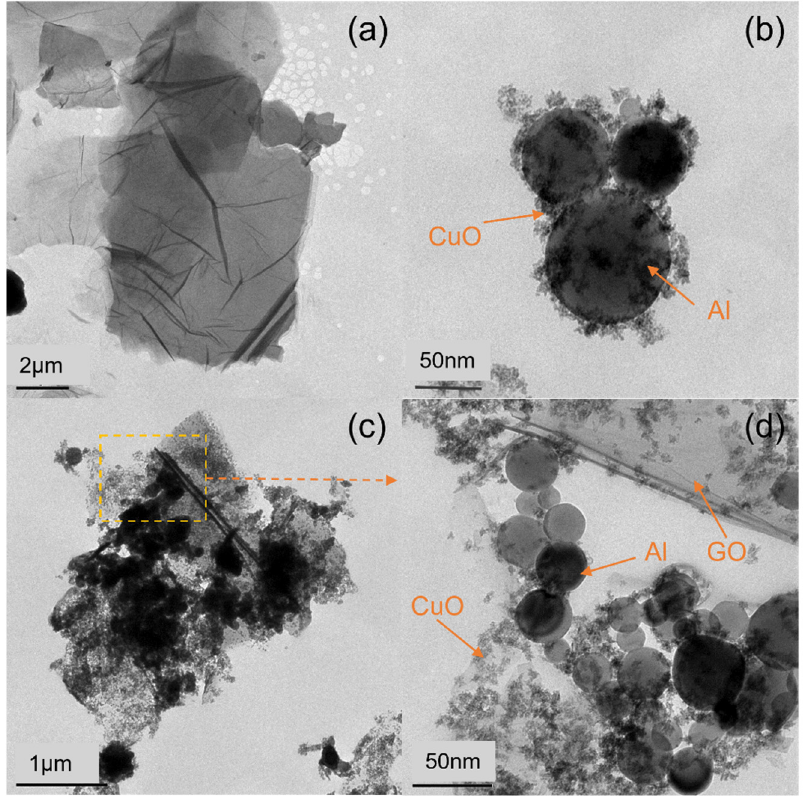
Figure 4. TEM images of ( a ) pure GO, ( b ) pure Al–CuO, ( c ) Al–CuO/GO with CuO:Al = 1.5:1, and ( d ) a partially enlarged image.